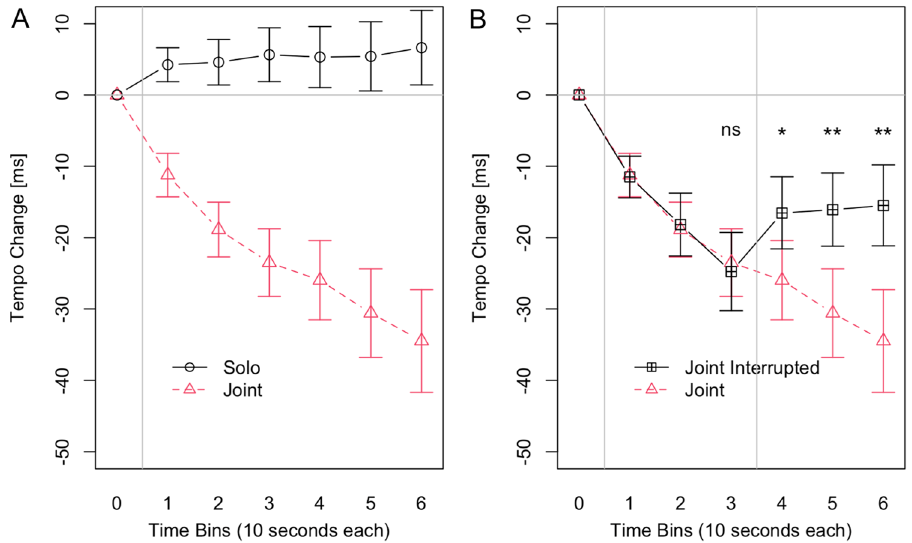
Figure 1. In Time Bin 0 participants synchronized with a metronome set to a target Inter-Onset-Interval of 500 ms. In Time Bins 1–6 participants were asked to maintain the initial tempo. Tempo Change on the y-axis shows how participants changed their tempo in each Time Bin compared to the initial tempo in bin 0. ( A ) Participants gradually became faster in the Joint condition but not in the Solo condition. ( B ) In the joint interrupted condition where the auditory feedback of the partner’s taps stopped after Time Bin 3 the tempo increase immediately stopped. The tempo increase continued in the joint condition in which participants continued to receive auditory feedback of the partner’s